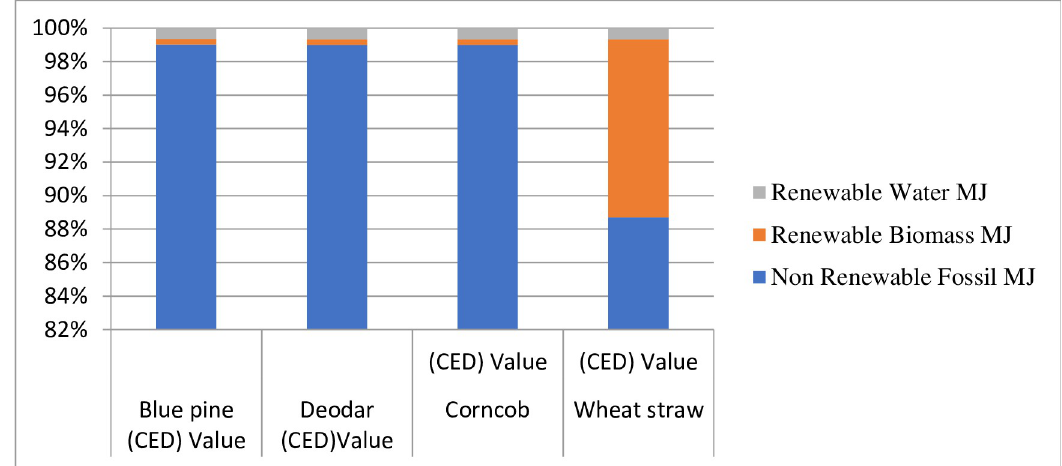
Fig 6. Cumulative energy demand (CED) of biomass pellets biofuel.